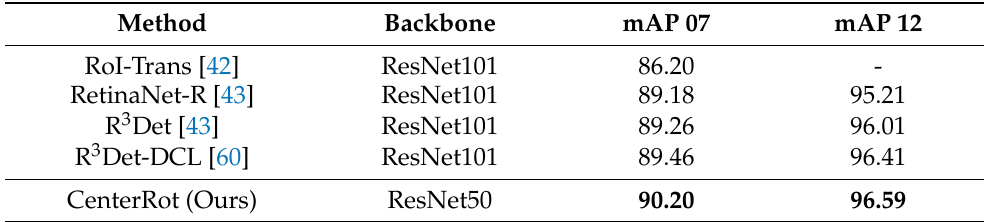
Table 3. State-of-the-art comparison of HRSC2016. mAP 07(12) means using the 2007(2012) evaluation metric.